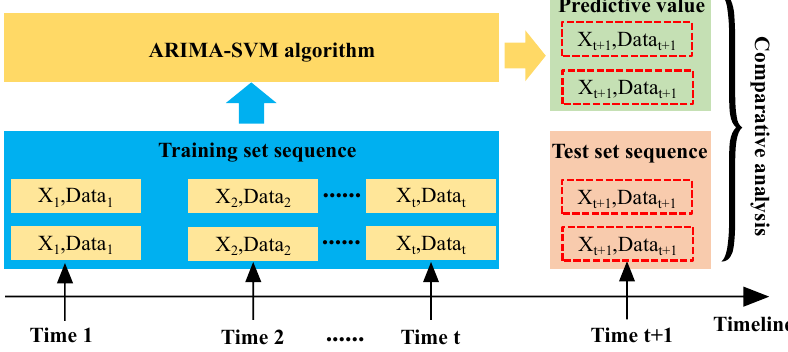
Figure 3. Schematic diagram of the principle of the gas concentration prediction framework.